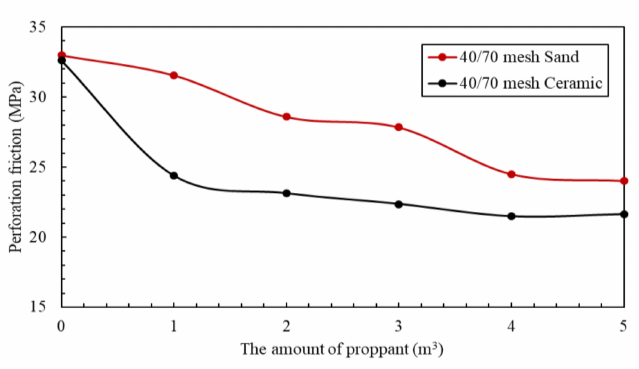
Figure 11. Perforation friction vs. proppant dosage at different proppant types.